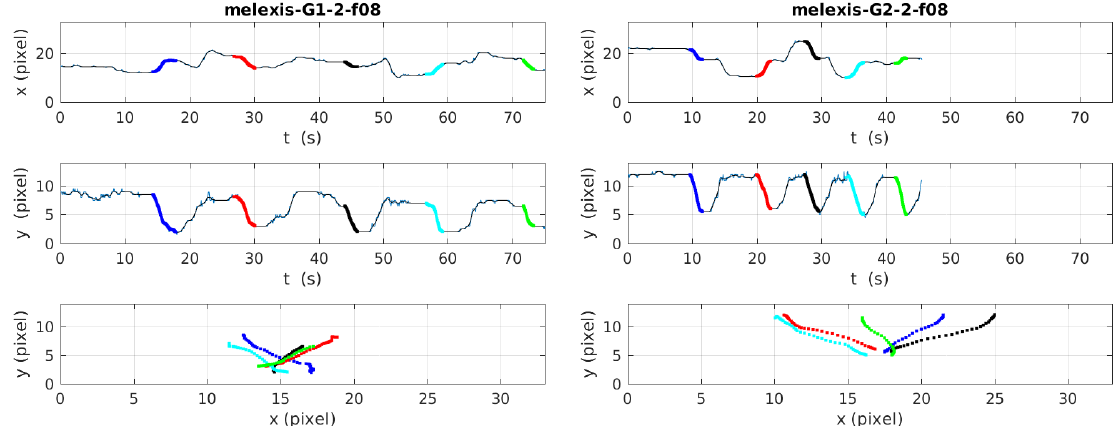
Figure 6. Trajectories of two different volunteers during the falls of type 8 (forward, knee flexion).